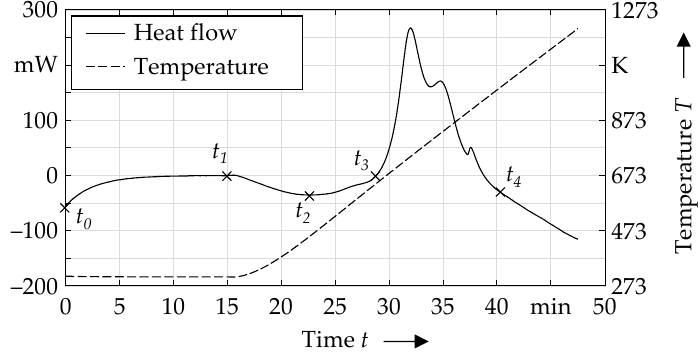
Figure 4. Heat flow and temperature curve for a DSC measurement (experiment no. 41, see Appendix A).